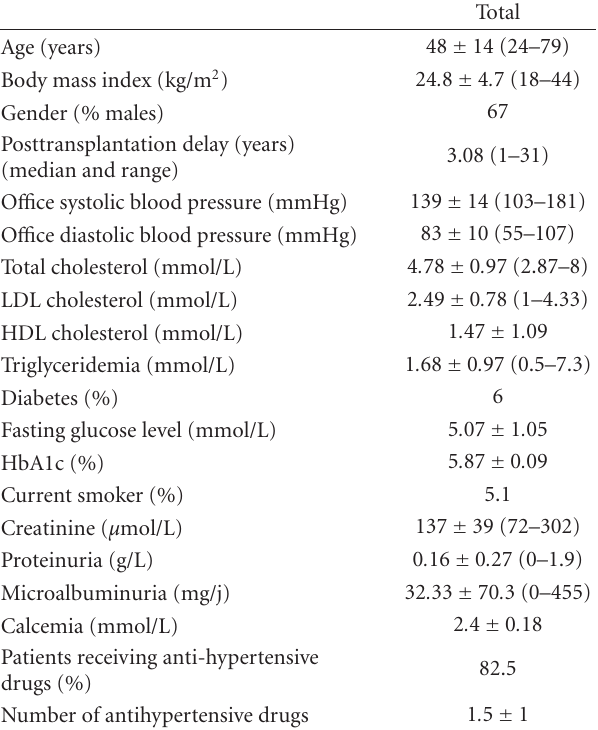
Table 1: Demographic characteristics (mean ± SD, range). Table 2: Number of patients with controlled and uncontrolled home and o ffi ce blood pressure